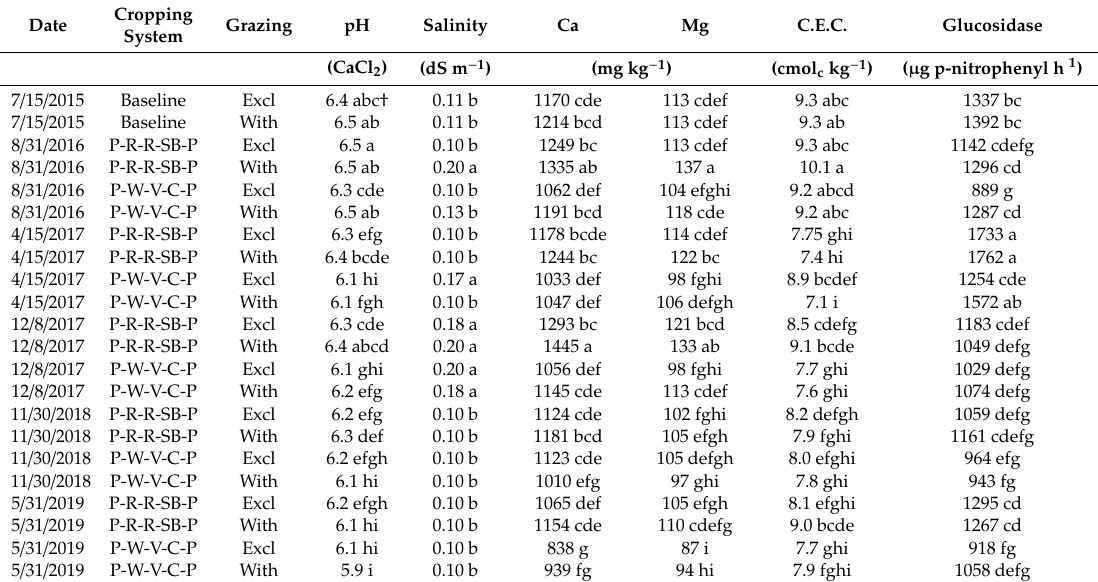
Table 8. pH, salinity, Ca, Mg, CEC, and glucosidase as a function of the interaction between sampling date, cropping systems and grazing in Pennsylvania